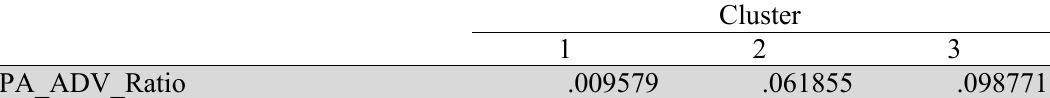
Initial Cluster Centers